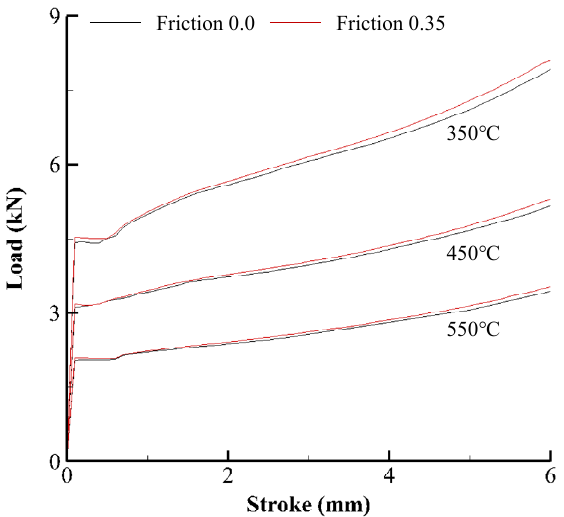
Figure 4. Effect of frictional coefficients on the predicted CLSCs.